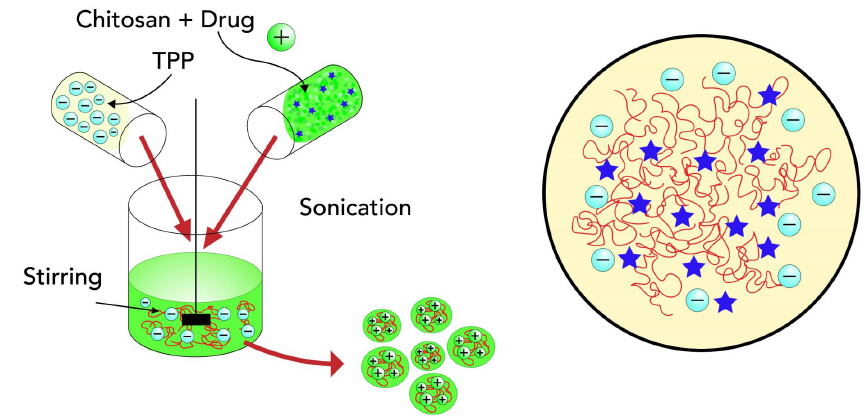
Figure 4. Synthesis of nanoparticles based on the ionic crosslink